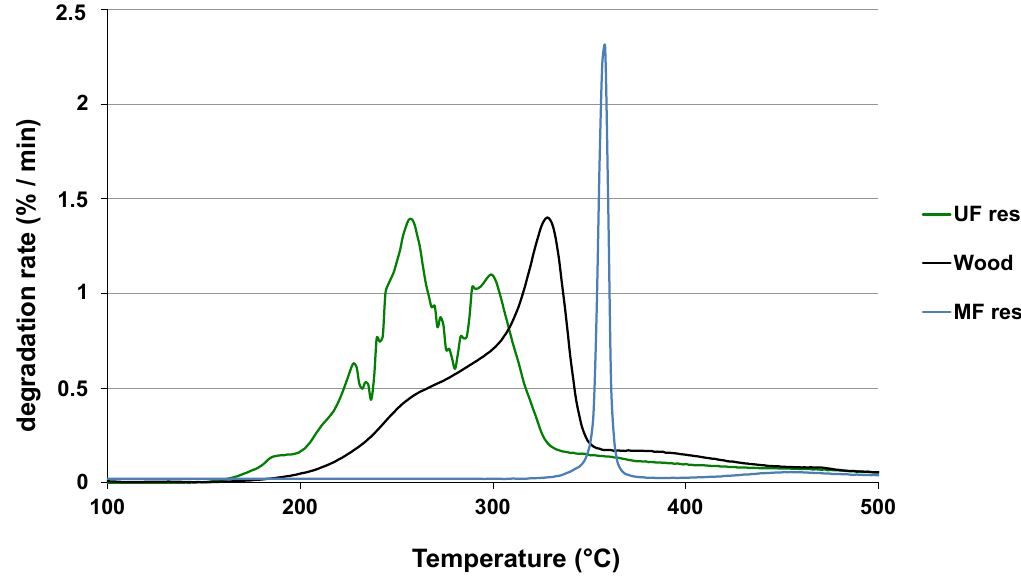
Figure 4. Degradation rate of wood, UF resin, and MF resin as a function of temperature [32].